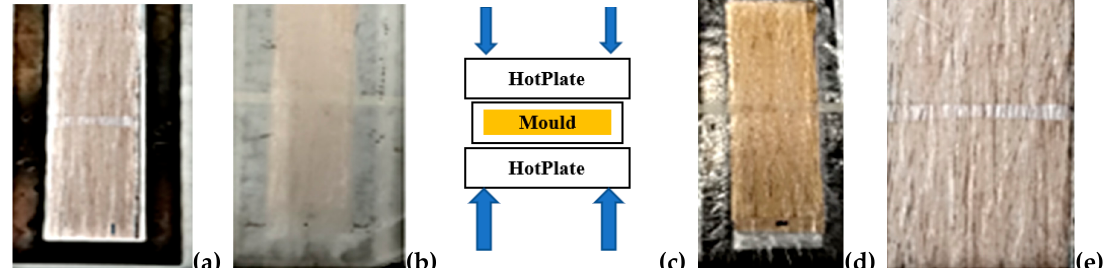
Figure 6. Preparation of bamboo fibre-PP composites: ( a ) bamboo fibre prepreg, ( b ) stacking sequence of prepregs, ( c ) compression molding, ( d ) composite in the mold, and ( e ) produced composite sample.